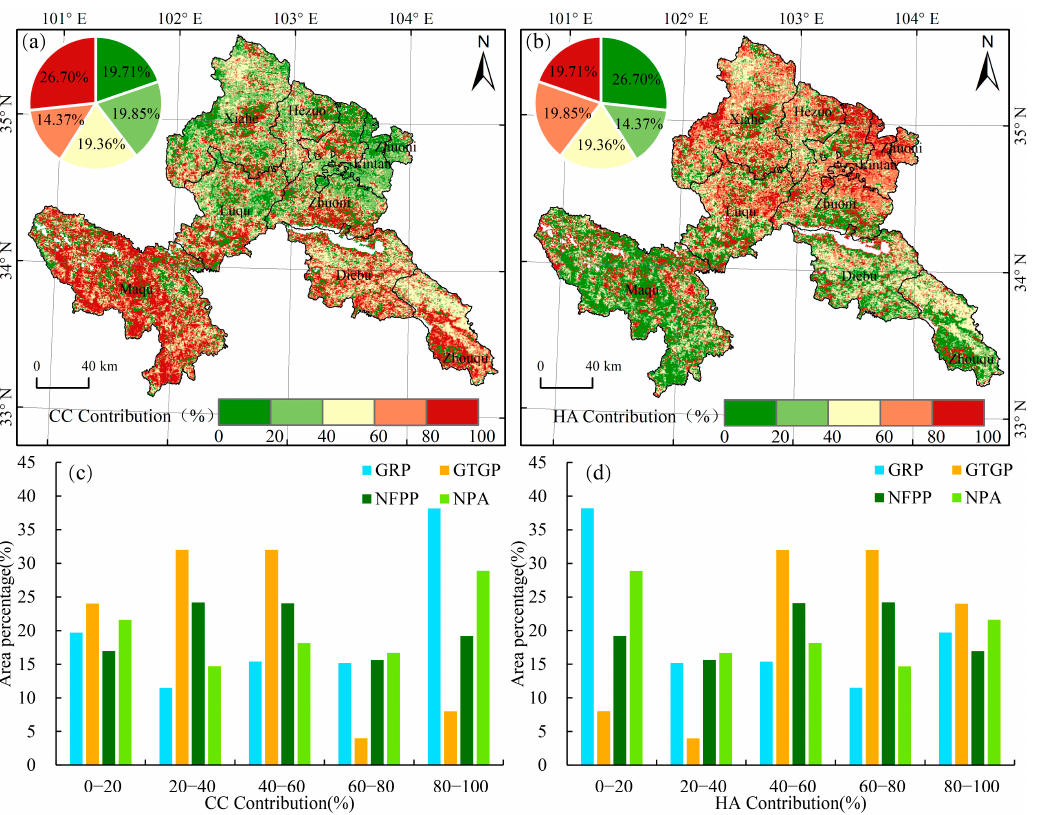
Figure 3. Spatial distribution and statistics of the relative contribution of climate change (CC) ( a , c ) and human activities (HA) ( b , d ) on vegetation changes under different projects during 2000–2020.